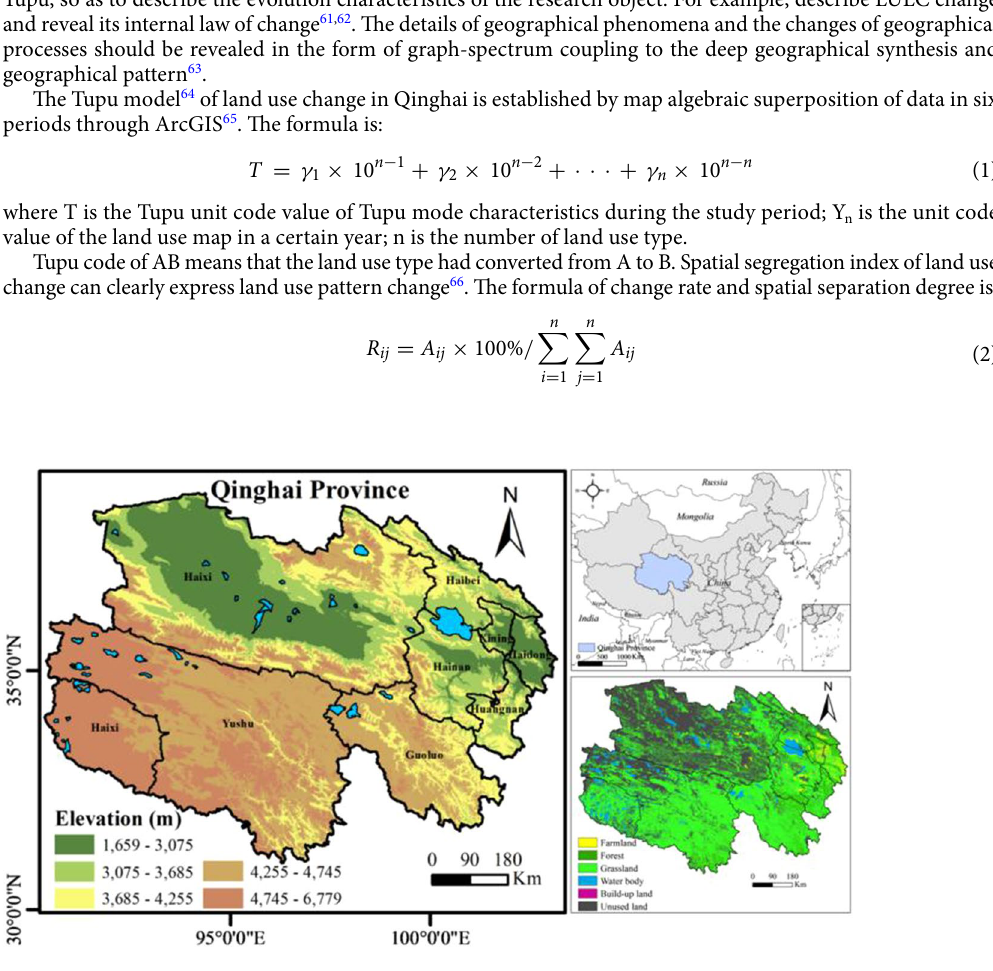
Figure 1. Location of the study area (made in ArcGIS 10.4.1, https:// www. esri. com/ zh- cn/ arcgis/ produ cts/ arcgis- deskt op/ resou